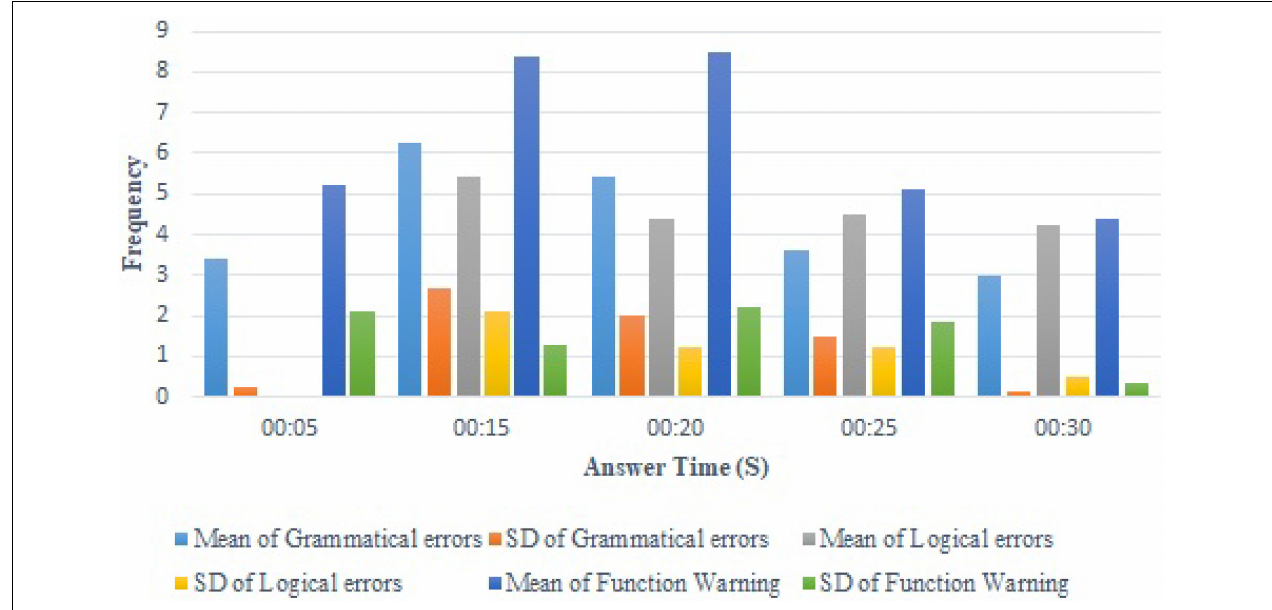
FIGURE 2 | Statistics on the detailed analysis of recorded